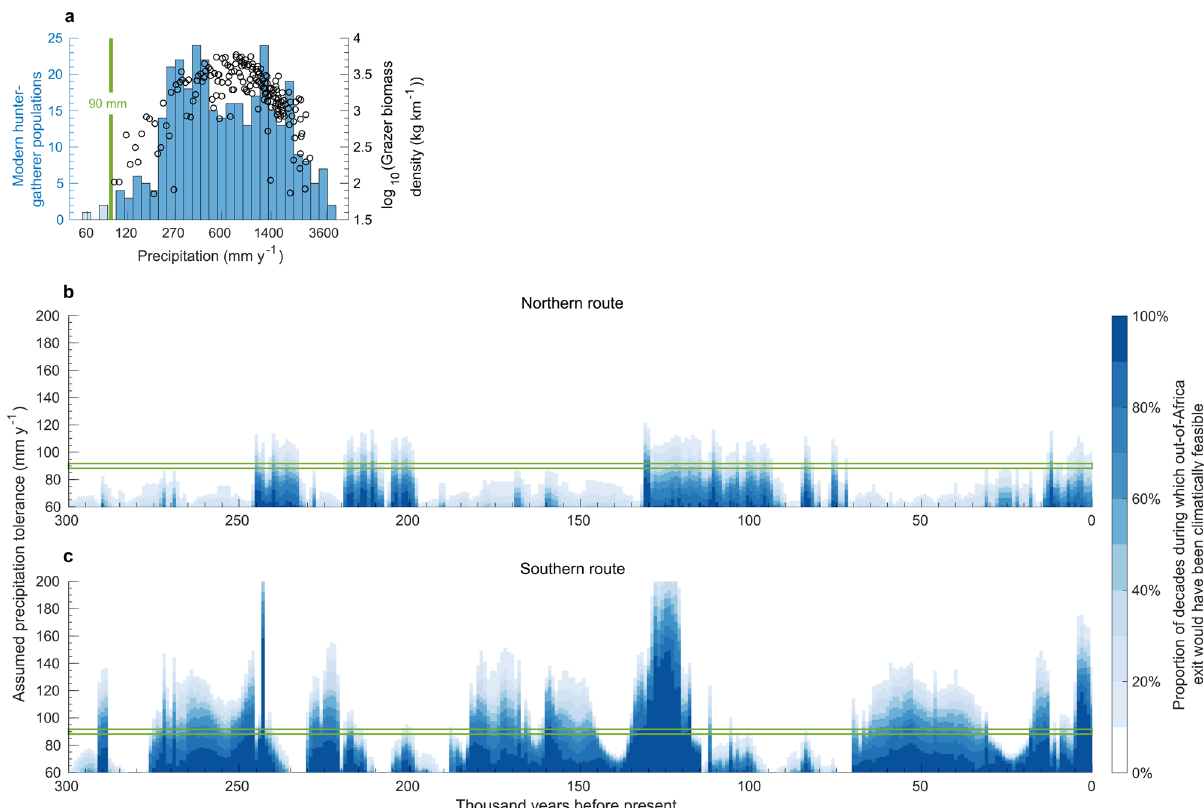
Fig. 2 Climatic Windows of opportunity out of Africa. a Distribution of modern hunter-gatherer populations (histograms) 36 under different precipitation levels and in relation to grazer biomass density 39 (black markers). Transparent bins correspond to populations located in close vicinity of a water source, which are not considered to be constrained by precipitation. b , c Percentage of decades within a given millennium ( x -axis) during which a connected path between Africa and Eurasia along the b northern and c southern route existed for a given hunter-gatherer tolerance to low precipitation ( y -axis). The green band represents our empirically estimated threshold of 90 mm y − 1